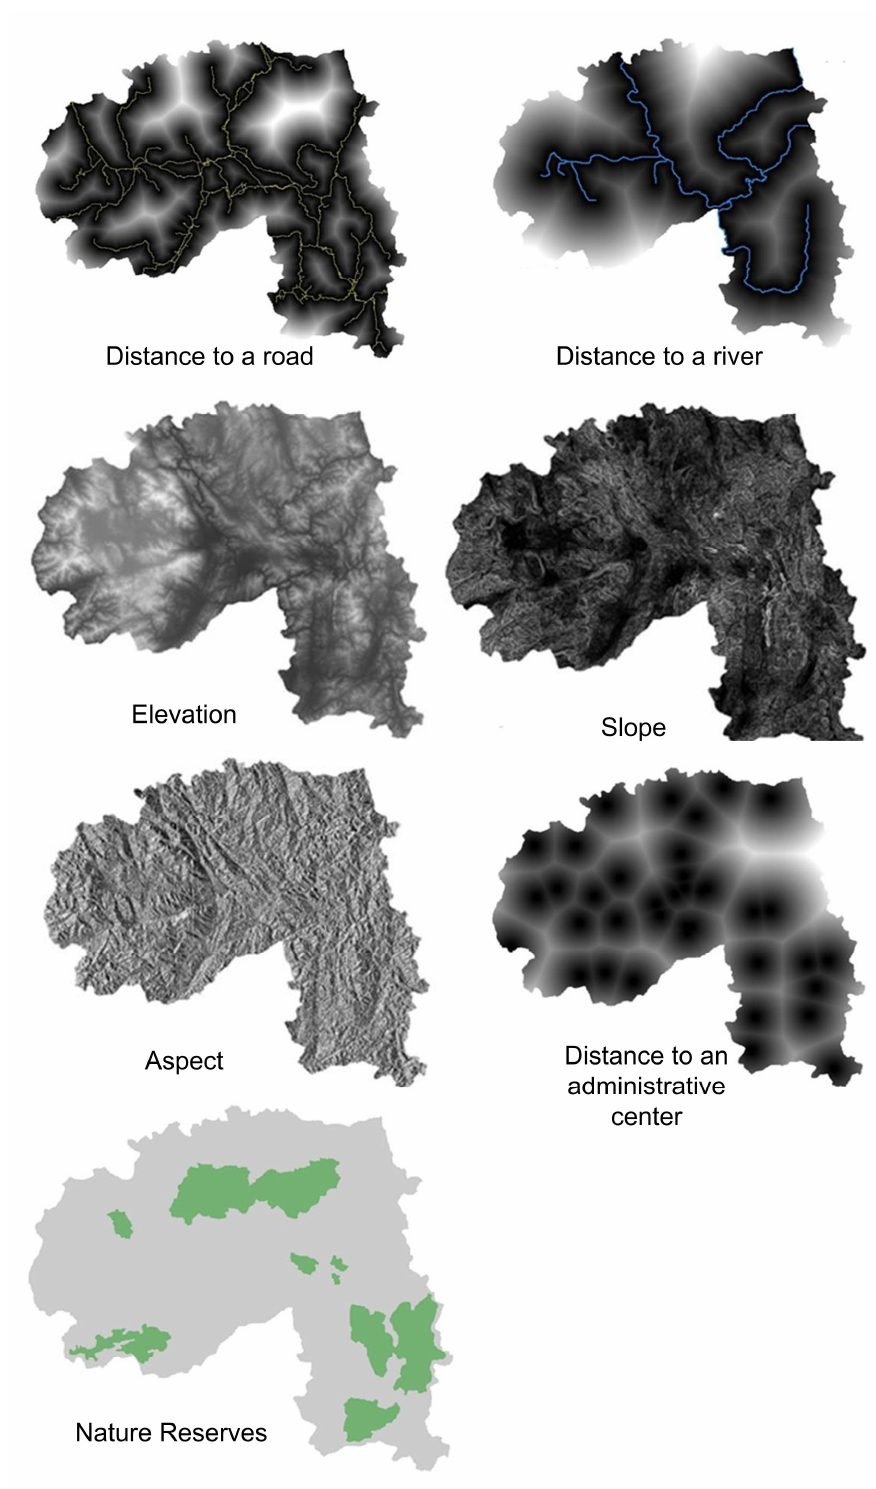
Figure 6. Influencing factors of land use change in Xishuangbanna region. Cramer’s V coefficients (Table 4) were calculated to measure the correlation between the above-mentioned factors impacting land use change and land distribution. The larger the value, the stronger the